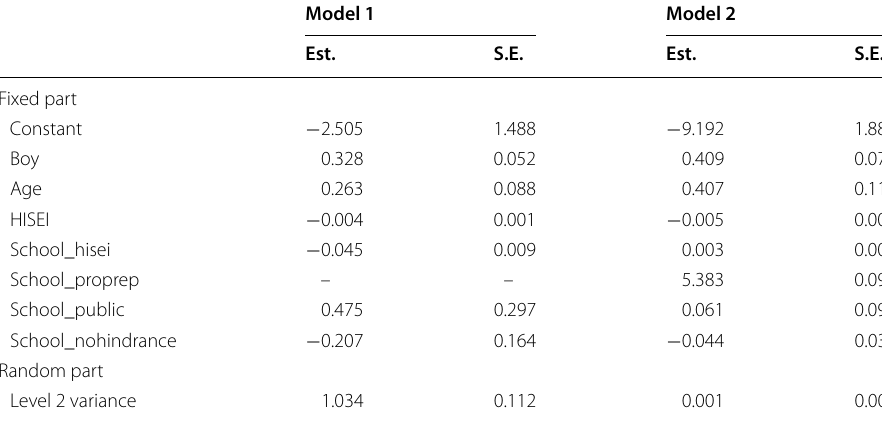
Table 4 Logistic multilevel model